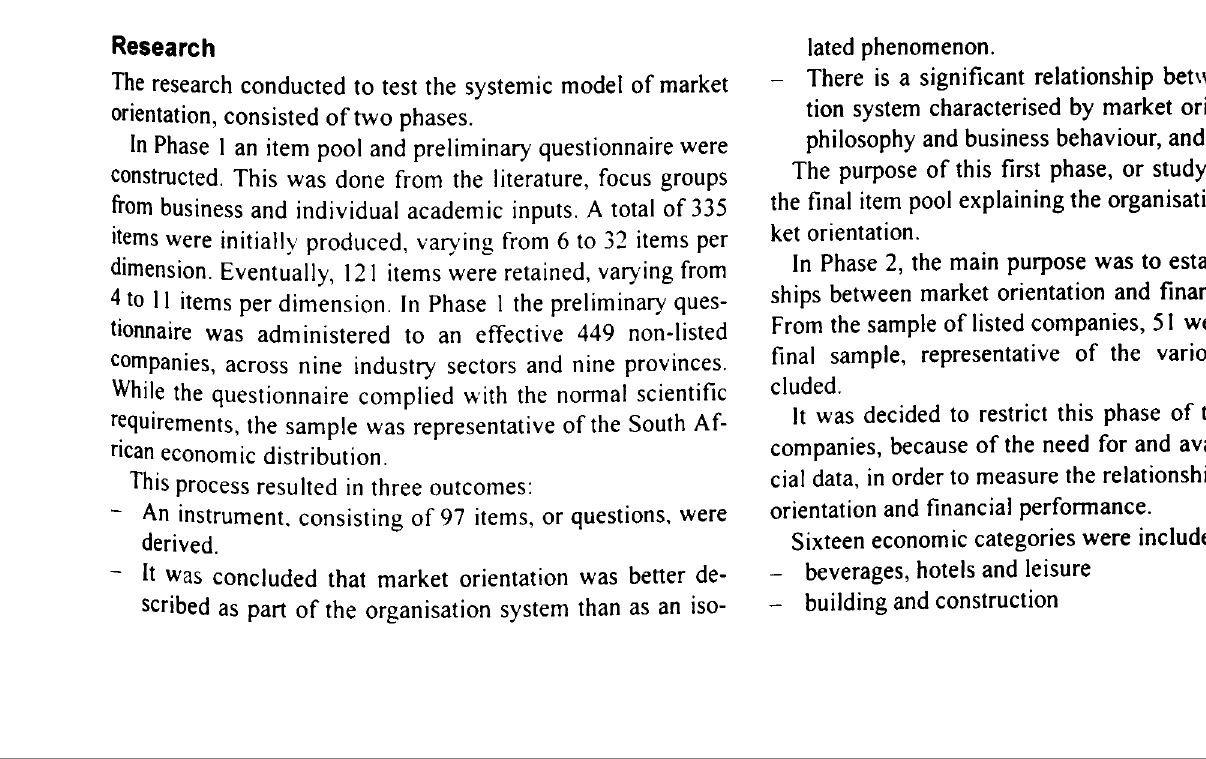
Figure 2 Constructs of the organisation S) stem to which market orientation belongs